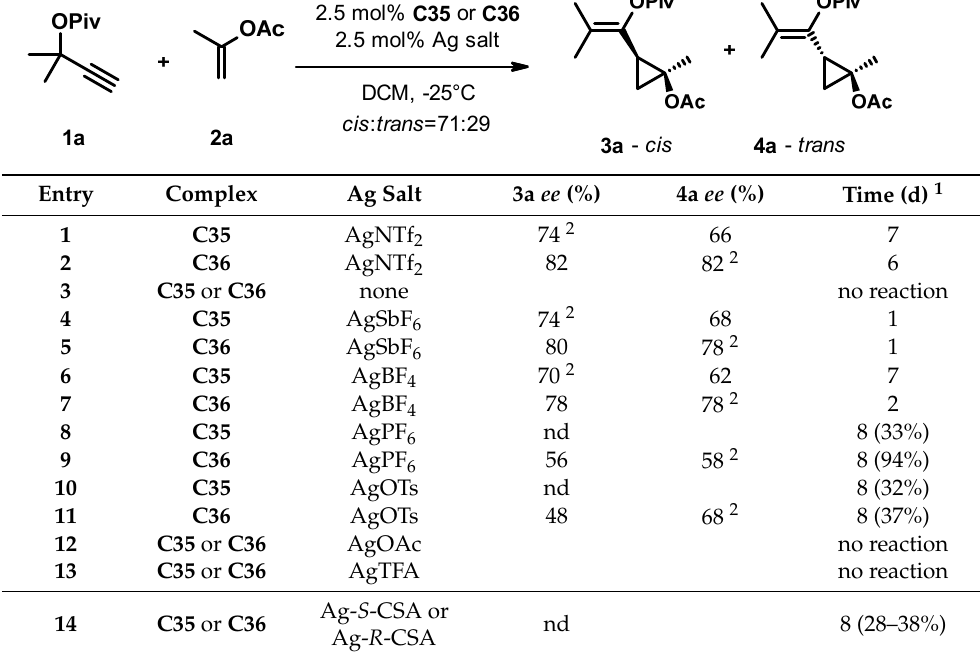
Table 2. The effect of the added silver salt on the asymmetric